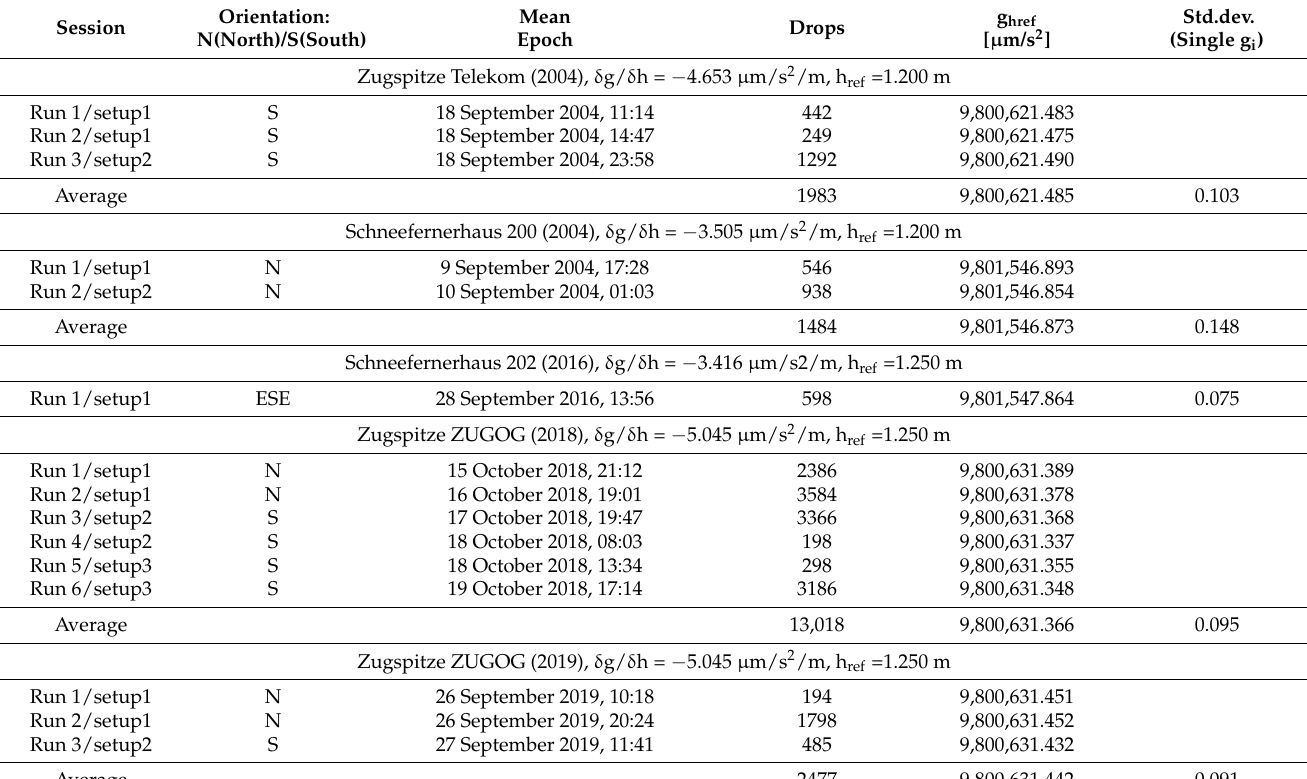
Table 3. Absolute gravity values of the FG5-220 measurements at the top of Mt. Zugspitze (facilities of Environmental Research Station Schneefernerhaus, DFMG Deutsche Funkturm GmbH and GFZ German Research Centre for Geosciences). The gradient insensitive sensor height depends on the gravimeter setup and is about 1.25 m above floor level for the 2019 setups (FG5-220, X-version) and 1.20 m for the 2004 setups with the original gravimeter version of FG5-220. The average of a station determination has been calculated as the arithmetic mean of the different setups. Before, a setup mean has been calculated as a weighted mean of the runs (no. of drops is the weight of a run). Std.dev. is the standard deviation calculated from the drop